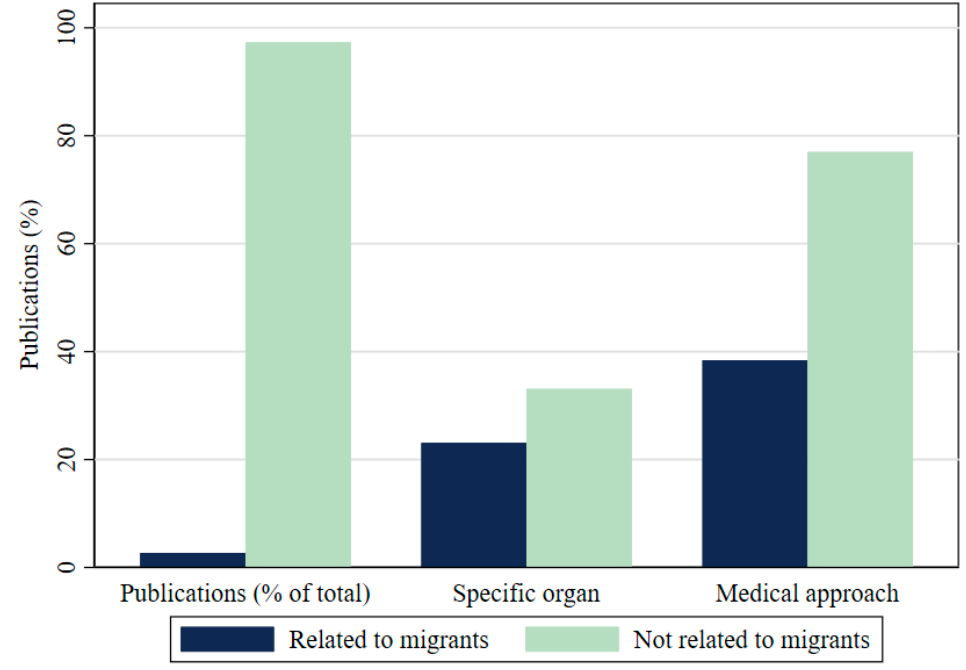
Figure 5. Migrant inclusion / exclusion in THBOR research.